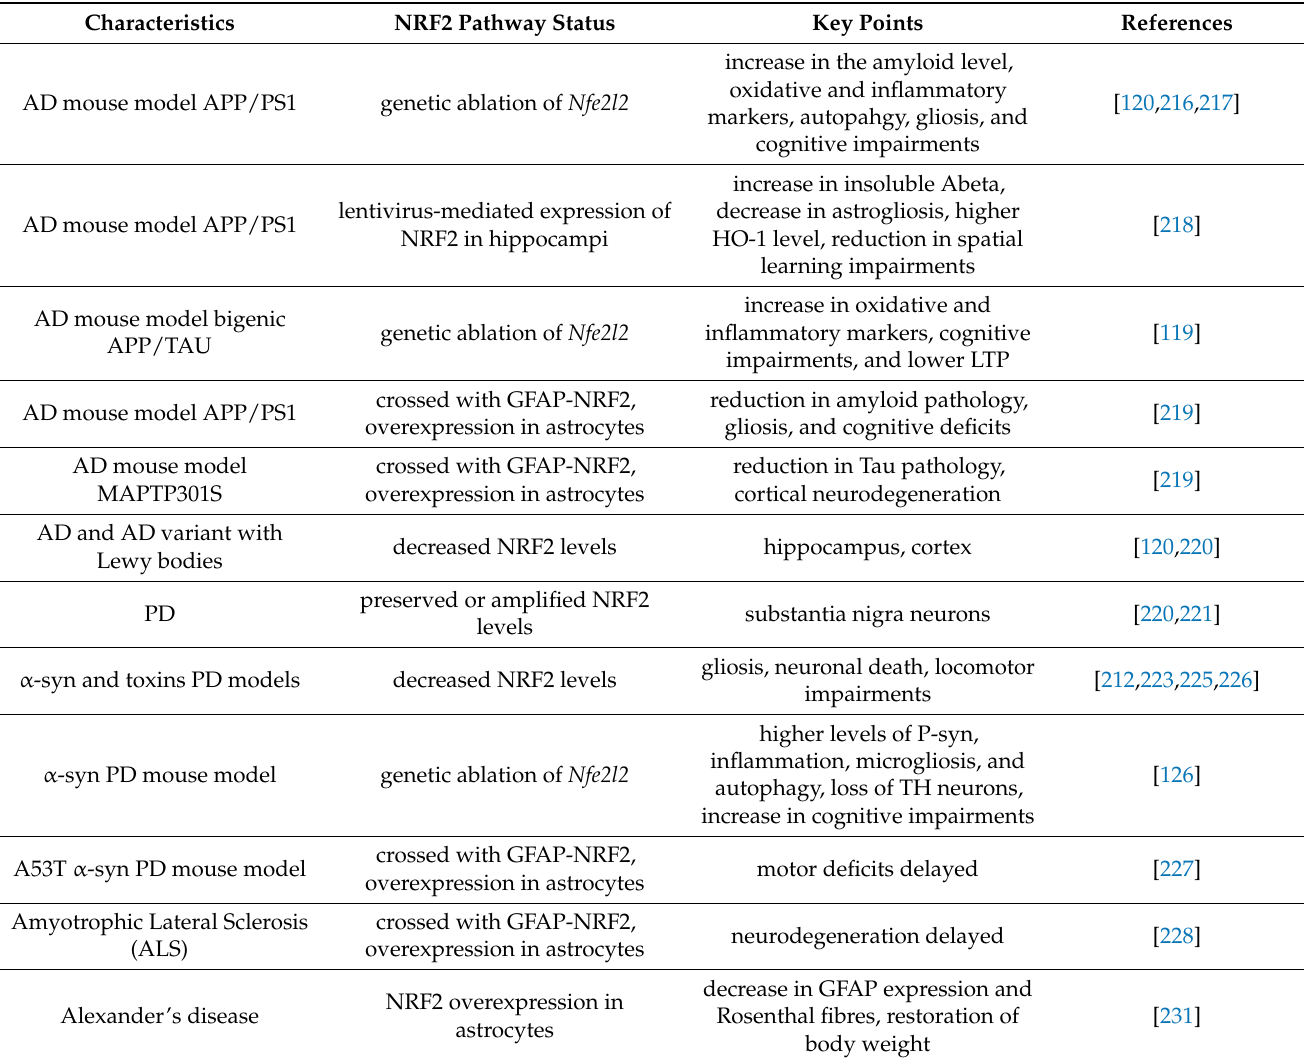
Table 4. NRF2 and